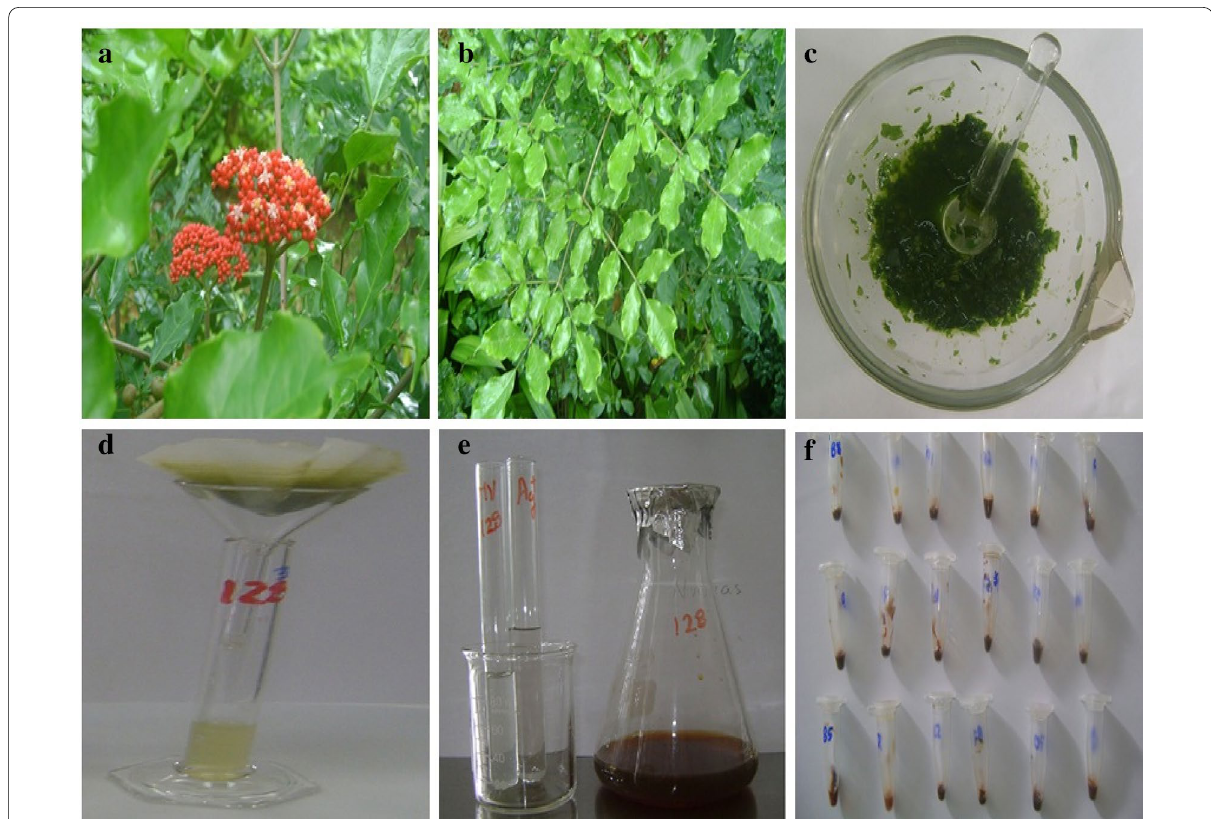
Fig. 2 Biosynthesis of SNP from Leea coccinea ( Lc ) leaves. a Shrubs of Lc with flowers; b leaves of Lc ; c maceration; d filtration; e reaction of bio-reduction con Ag + ; f